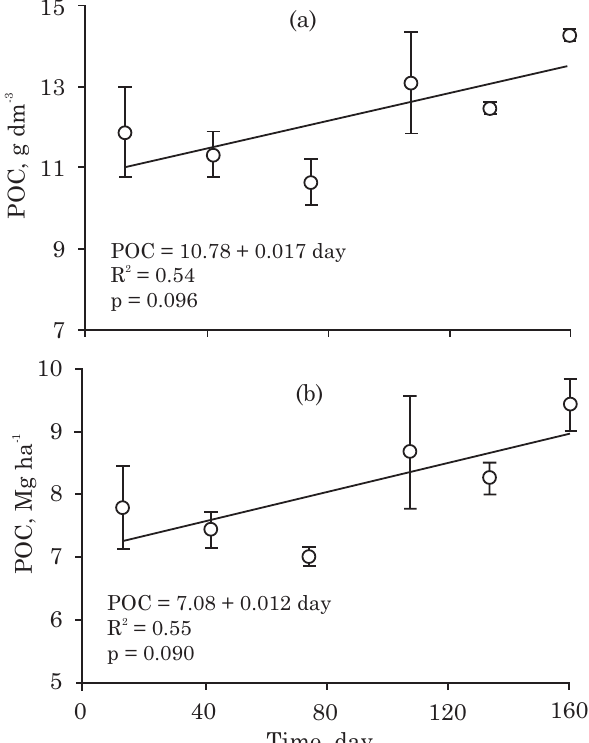
Figure 4. Particulate organic carbon (POC - fraction > 53 μμμμμ m) content (a) and stock (b) in the 0-5 cm layer over time after black oat management. Vertical bars indicate the standard error of the